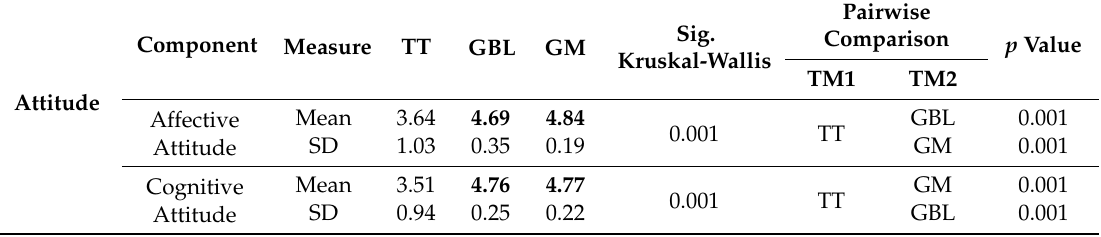
Table 4. Descriptive statistics (with means of the experimental groups in bold) and pairwise comparison of teaching methods for the Attitude constructs.